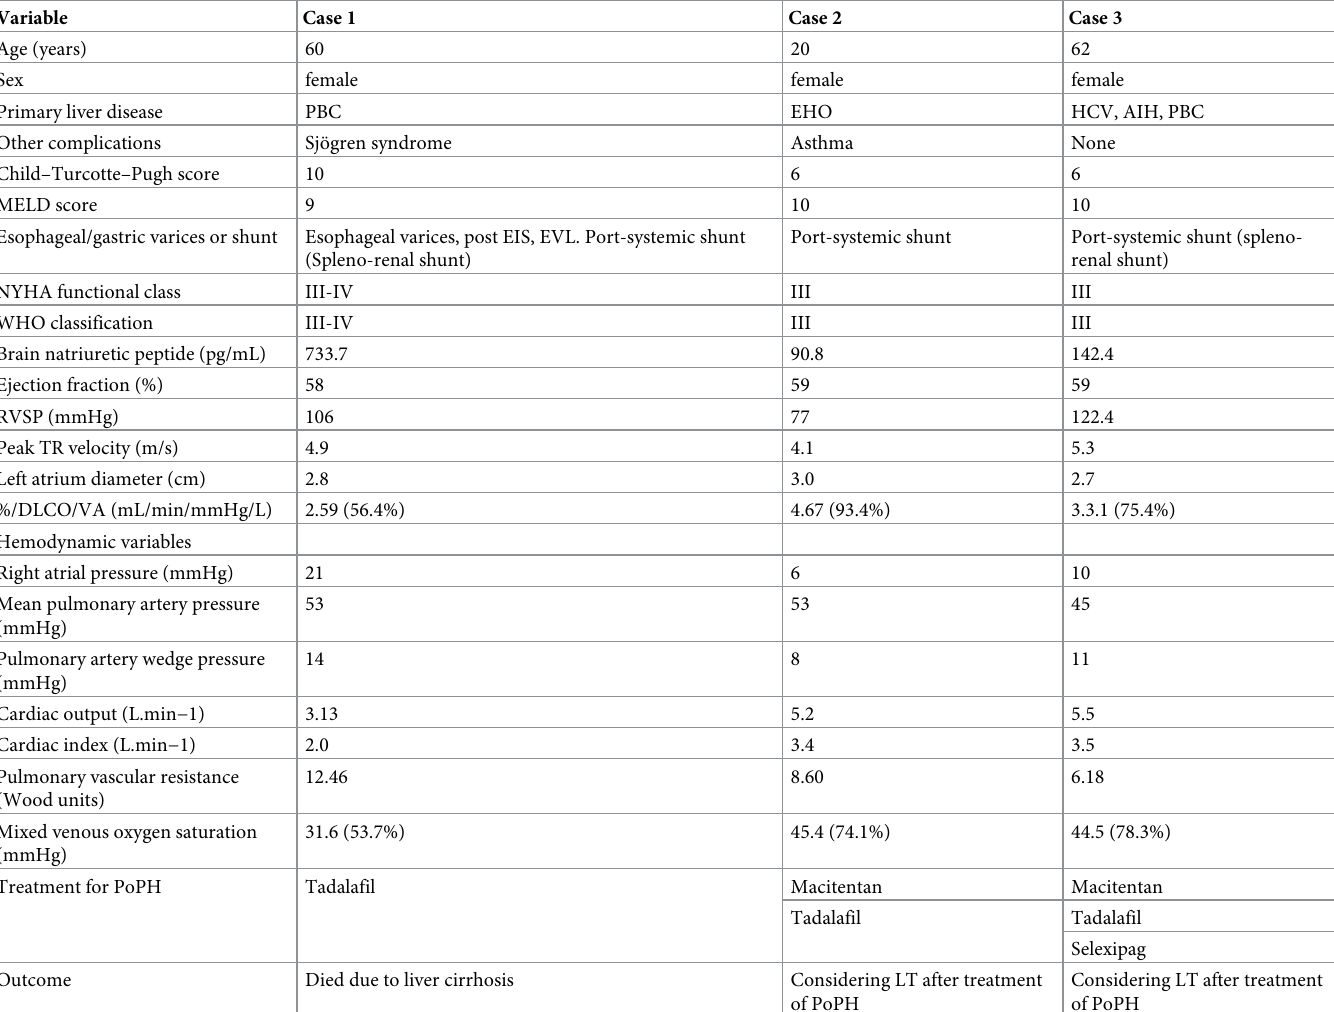
Table 3. Characteristics of patients with